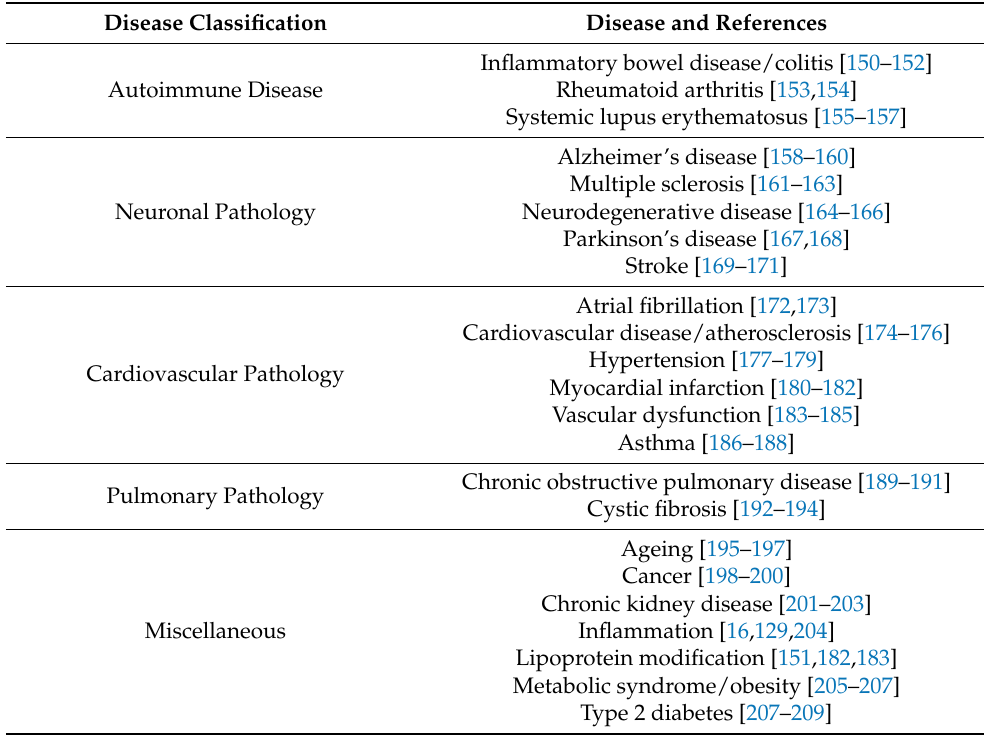
Table 2. Occurrence of MPO in various